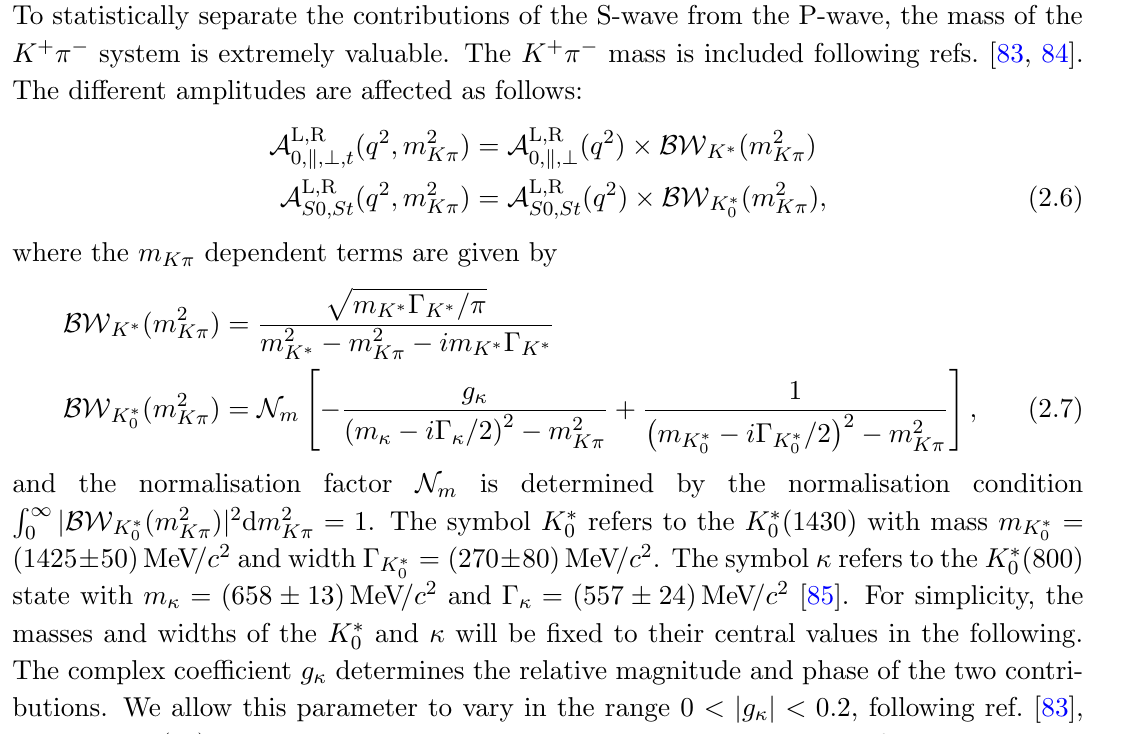
Figure 1. (Blue) jBW K (cid:3) ( m 2 ) j 2 , (teal) jBW K (cid:3) K(cid:25) Re( BW y ( m 2 ) BW K (cid:3) ( m 2 )) when varying g (cid:20) and the relative phase between P-wave and S- K(cid:25) K(cid:25) K (cid:3) 0 wave as discussed in the